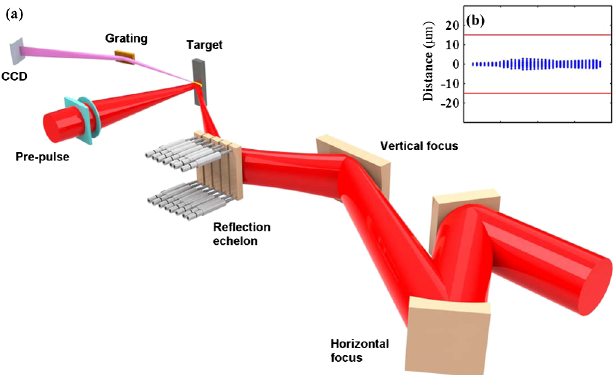
FIG. 1. Schematic representation of the setup used in the sub- 9-nm SXRL experiments. (a) A pair of cylindrical mirrors focuses the short-pulse beam at 35 (cid:3) grazing incidence on the target, creating a line focus of uniform width. A reflection echelon is used to obtain quasi-traveling-wave excitation. (b) Ray-trace simulation of the line focus on target. All rays fall within the linewidth defined by diffraction (red